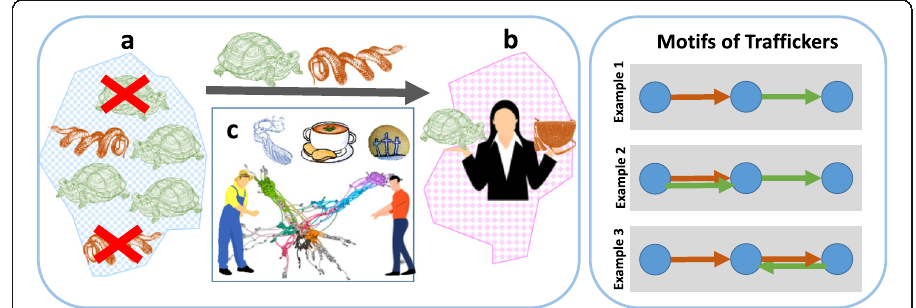
Fig. 1 Schematic model of wildlife trade of multiple species. (Left panel) Species are harvested from place “ a ” and smuggled to place “ b ” . In the process, populations of species are depleted in “ a ” and individuals are consumed (e.g. pets or derived products) in place “ b ” . Typically, only the mobility of species is considered; however here we also account for material and symbolic fluxes, as indicated in subpanel c. Traditional and religious customs, as well as diseases, are examples of material and symbolic content. Furthermore, species flux also depends on various social networks that facilitate trafficking. (Right panel) Shown are three proposed motifs that represent how traffickers could move between places (blue circles) trading multiple species (species1 flux = orange, species2 flux = green) across a generic path. Example 1 illustrates a trafficker exchanging species. Example 2 illustrates a trafficker trading multiple species simultaneously. Example 3 illustrates a trafficker trading multiple species at different times by way of returning via the same